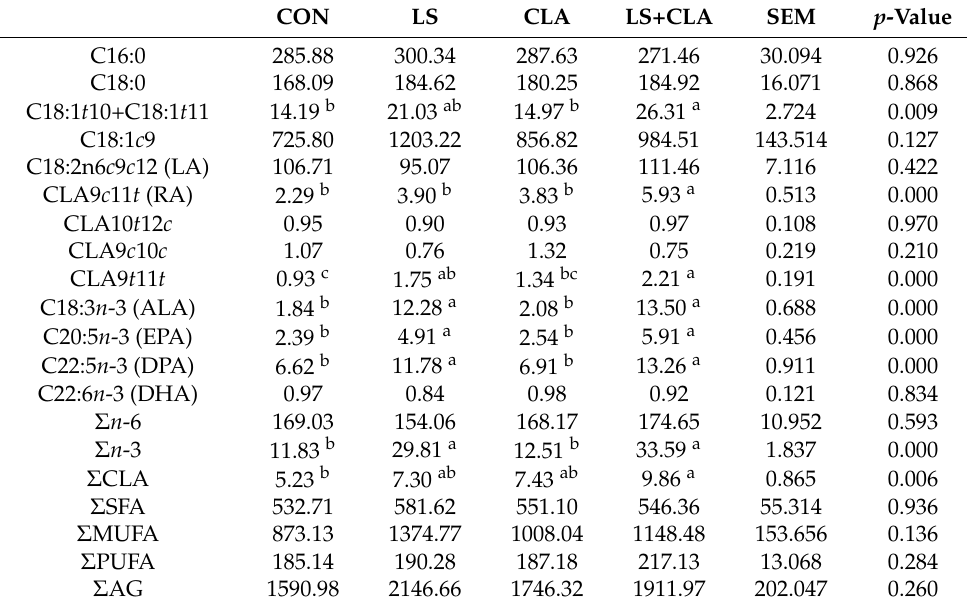
Table A1. Intramuscular fatty acid content (mg FA/100 g muscle) in young Holstein bulls fed with four different diets a (adapted from G ó mez et al.